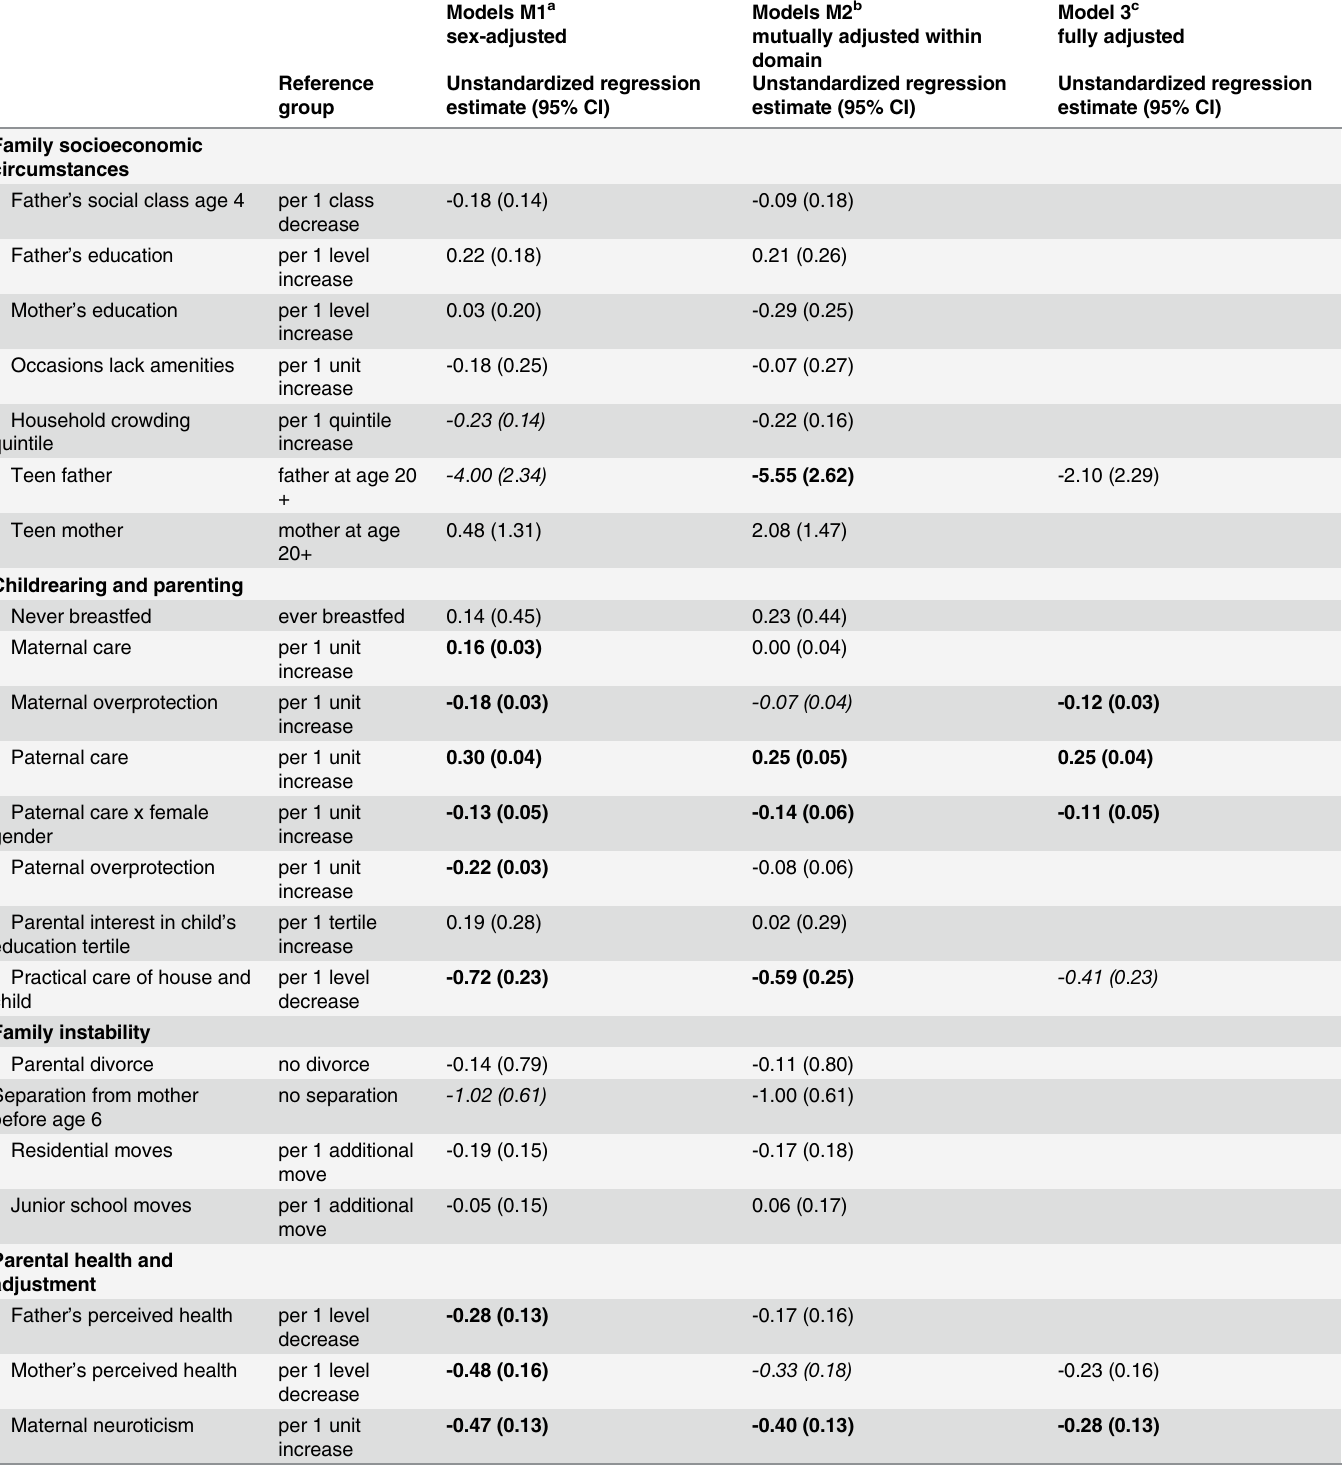
Table 2. Mutually adjusted associations between Warwick-Edinburgh Mental Well-Being Scores and domains of socioeconomic and psychosocial circumstances in childhood from multiple linear regression